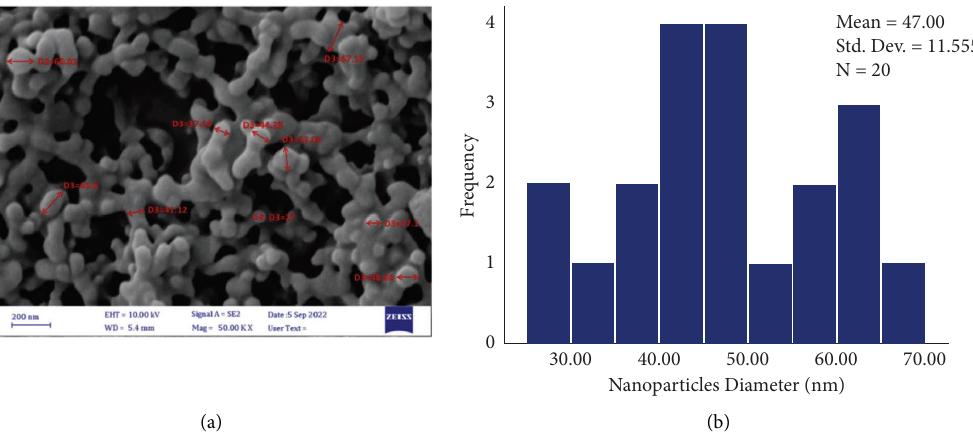
Figure 11: Size estimation of the nanoparticles using the FeSEM images and ImageJ software on the coated NiTiW. (a) Nanoparticles measurement. (b) Size distribution histogram of the nanoparticles.